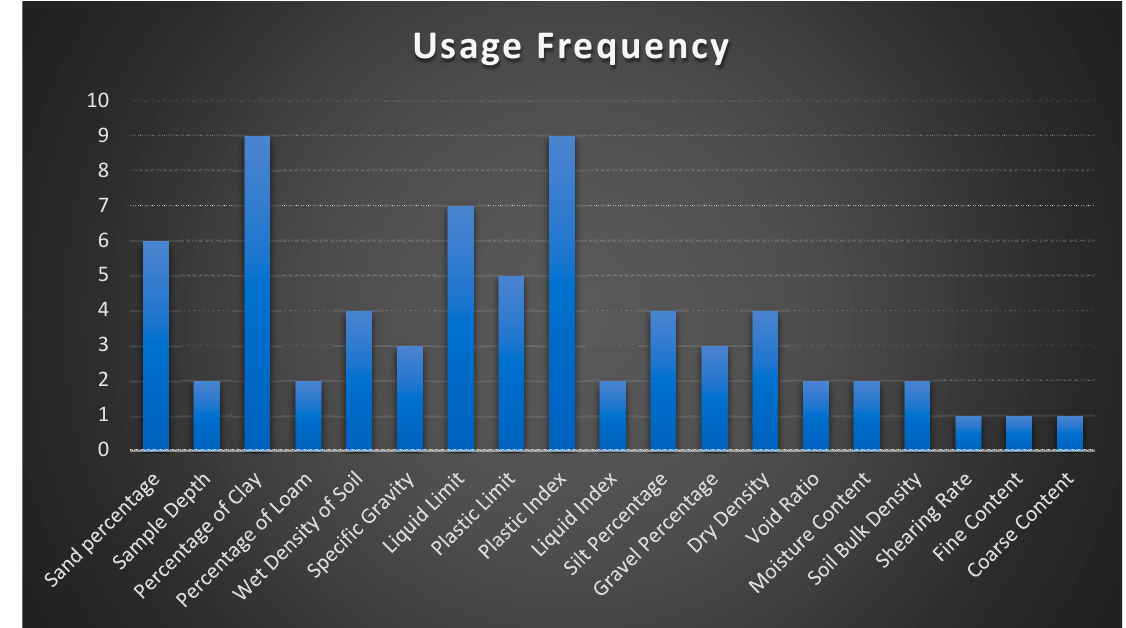
Figure 10. Usage frequency of input parameters for soil shear strength. Table 5. List of commonly used input parameters for deciding the strength of a clay/soil.